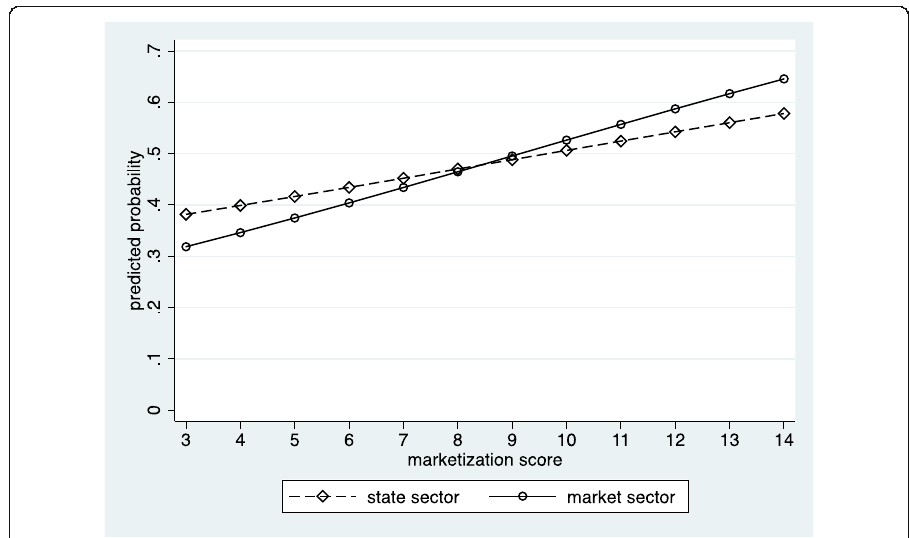
Fig. 3 The predicted probability of viewing guanxi as unfair (versus neutral), by marketization score and employment